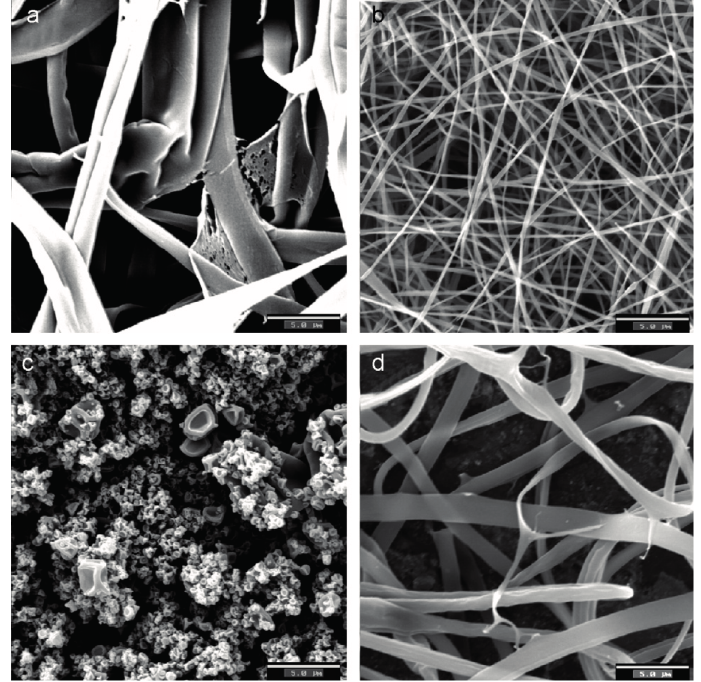
Figure 3. Selected SEM images of electrospun fiber networks for: ( a ) thick tubular fibers obtained from a concentrated zein solution of 50 wt %; ( b ) thin tubular fibers obtained from zein solutions with a tip to collector distance of 15 cm; ( c ) nanobeads obtained from a diluted zein solution of 12 wt %; ( d ) ribbon-like fibers obtained from the acidified zein solution. Scale markers are 5 mm in all cases. Reprinted with permission from Torres-Giner et al. [7]. Copyright 2007, Elsevier. Scale bar: 5.0